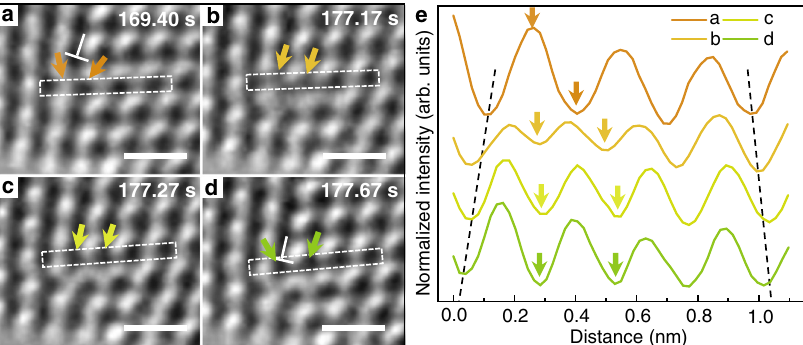
Fig. 4 Reconstruction of a dislocation core during negative climb. a – d A series of HRTEM images showing the reconstruction process. Scale bar: 0.5 nm. e The corresponding contrast intensity pro fi les extracted along the dotted rectangles in a –